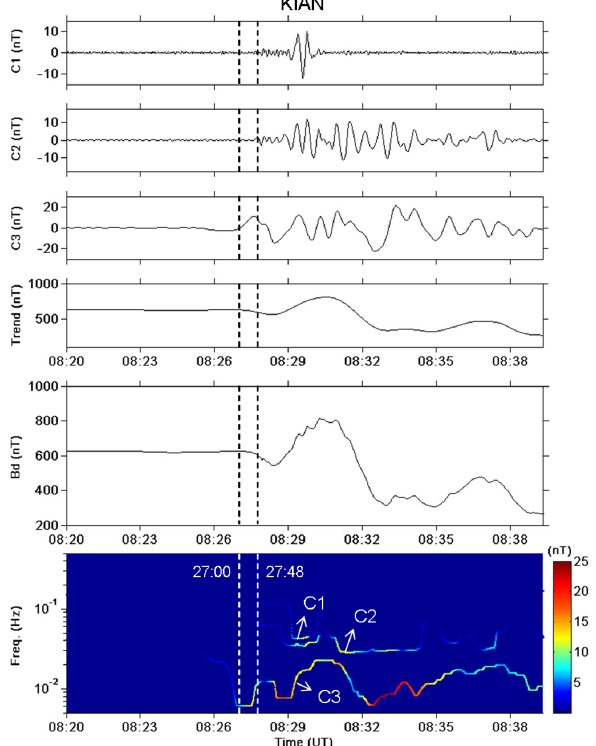
Fig. 10. The HHT analysis of the D-component magnetic field mea- sured at the BET magnetometer site. The dashed lines indicate the timings of the first and second arc